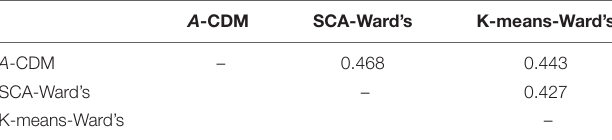
TABLE 5 | ARI table for ACDM, SCA and K